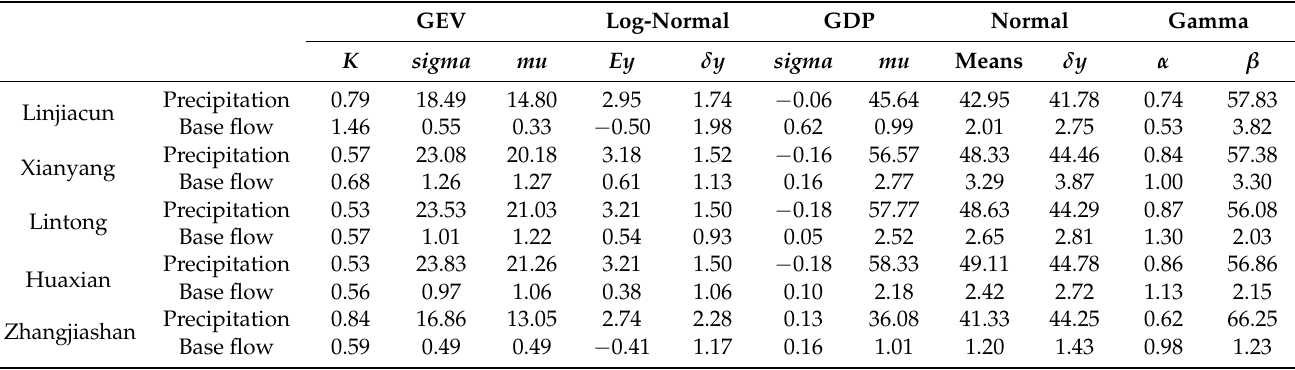
Table 3. Estimation of precipitation and base flow distribution parameters.